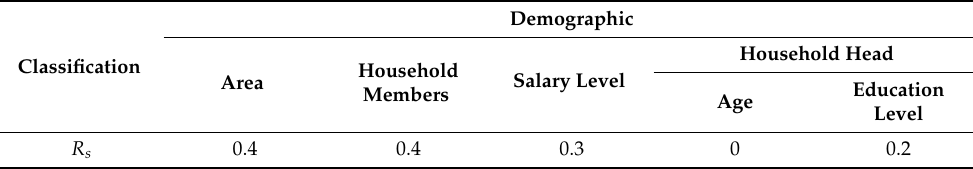
Table 1. Spearman’s correlation coefficient between energy consumption and demographic data.